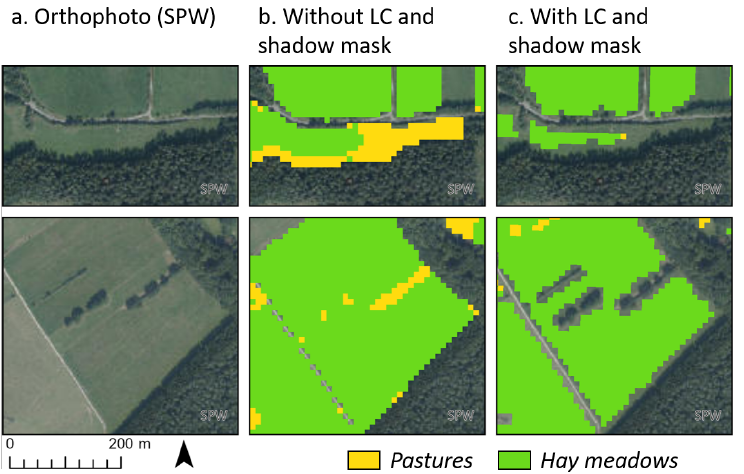
Figure 8. Comparison of the classification obtained with and without the land cover (LC) and shadow mask derived from very high resolution